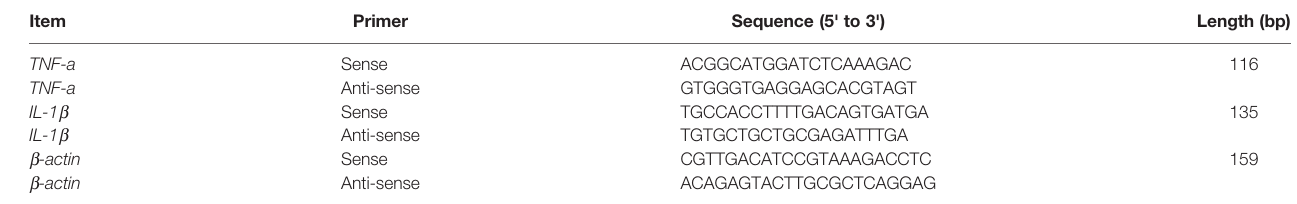
TABLE 2 | Primer sequences for TNF- a , IL-1 b and b -actin. Item